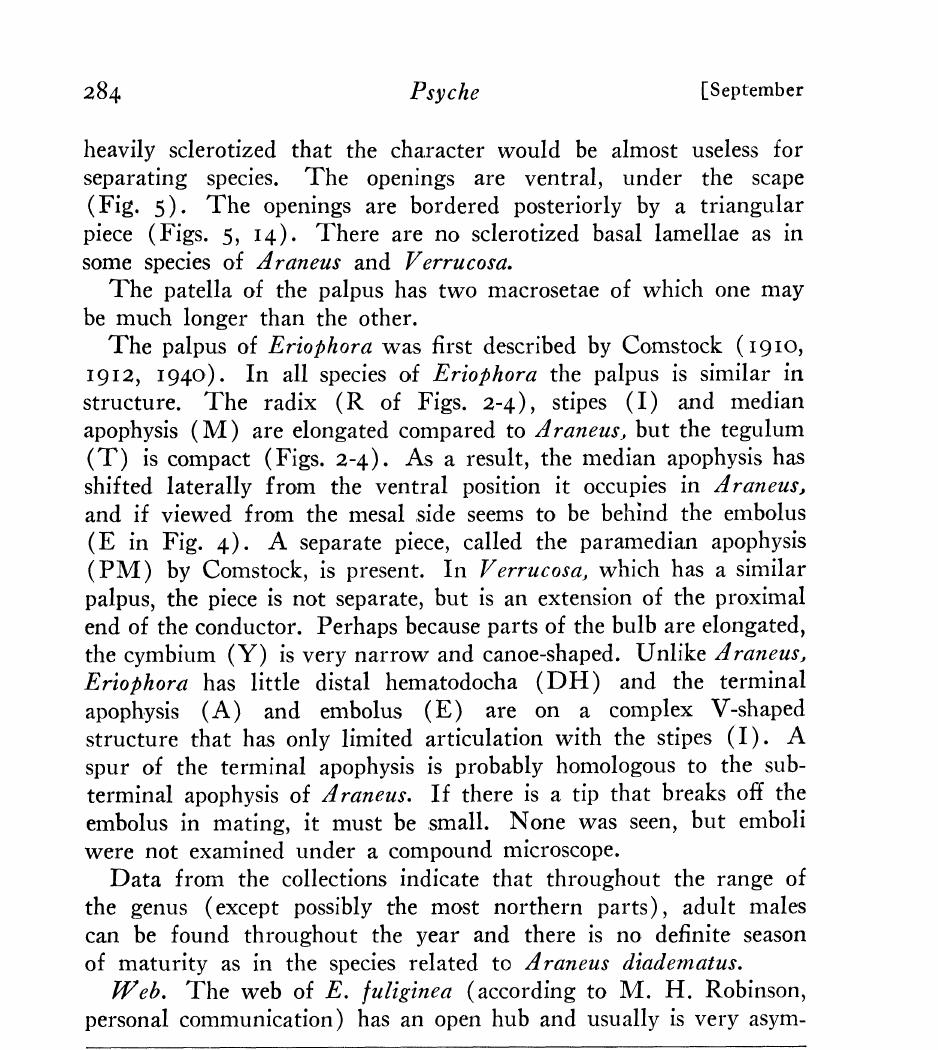
Figs. 2-6. Structure of Eriophora genitalia, diagrammatic. 2-4. Left palpus. 2. Expanded, mesal. 3. Expanded, lateral. 4. Contracted, mesal. 5-6. Base of epigynum. Figs. 7-9. Erlophora railla (C. L. Koch). 7. Male, fourth coxae and trochanters, ventral view. 8. Male, left second tibia and tarsus, ventral view. 9. Female, abdomen with epigynum, ventral